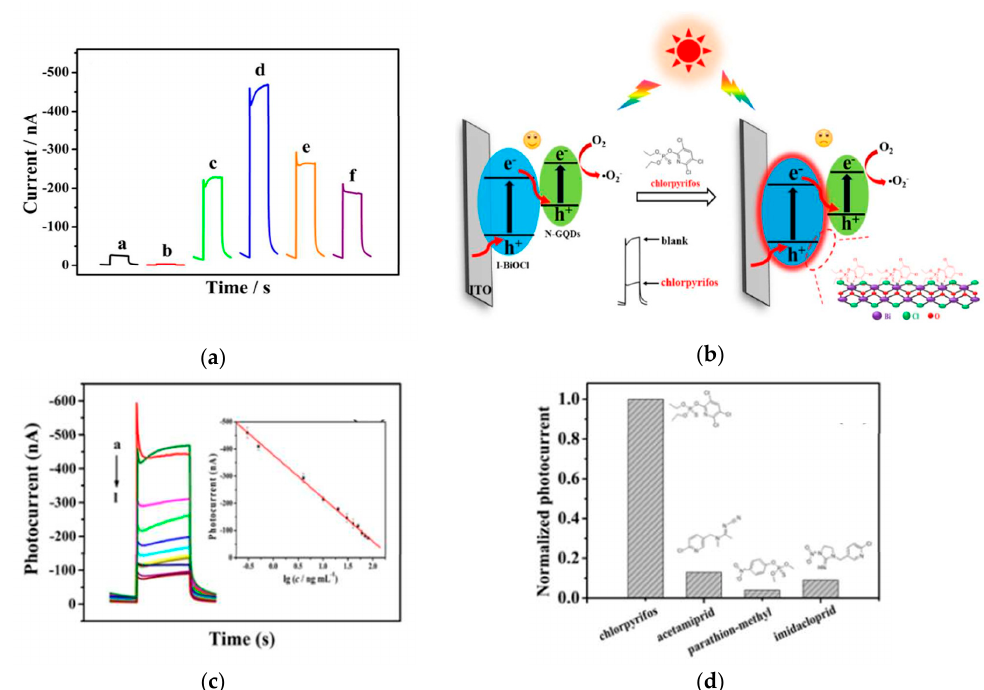
Figure 8. ( a ) Transient photocurrent of different photocatalysts (a: BiOCl, b: BiOI, c: I–BiOCl, d–f: I–BiOCl/N–GQDs- x ( x : the volume of nitrogen-doped graphene quantum dots (N–GQDs), x = 0.5, 1.0, 1.5)); ( b ) schematic diagram of the “signal-off” cathodic PEC sensor constructed by I–BiOCl/N–GQDs for selective detection of chlorpyrifos; ( c ) Photocurrent response of I–BiOCl / N–GQDs-0.5 in